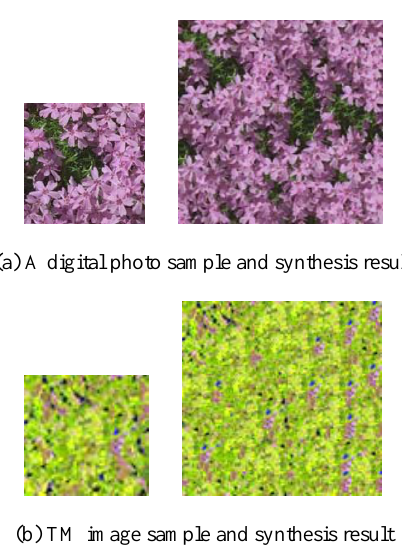
Figure 4. Texture synthesis of different samples